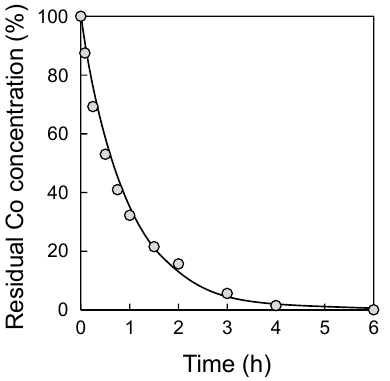
Figure 6. Co concentration (50 ppm) decay in water during the adsorption of Co(II) on PE/PP- g -GMA-IDA fabric.